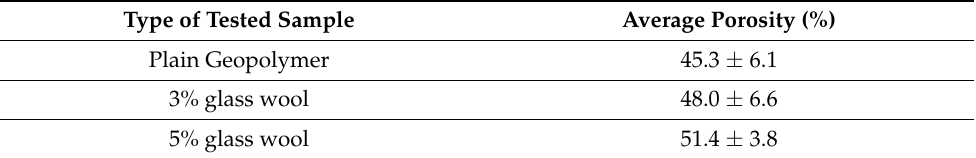
Table 3. The average porosity results of the produced geopolymers.